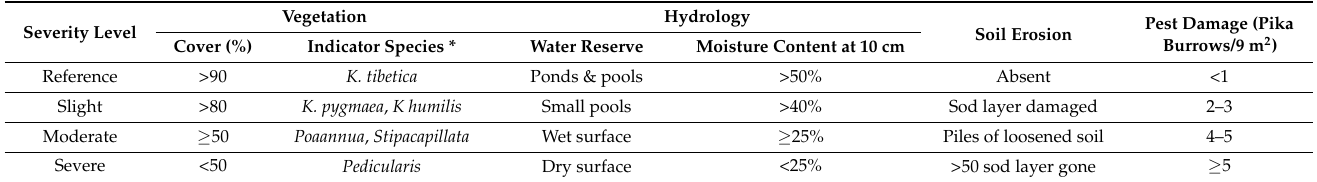
Table 1. Indicators of plateau swampy meadow degradation and criteria for grading degradation severity of swampy meadows in the study